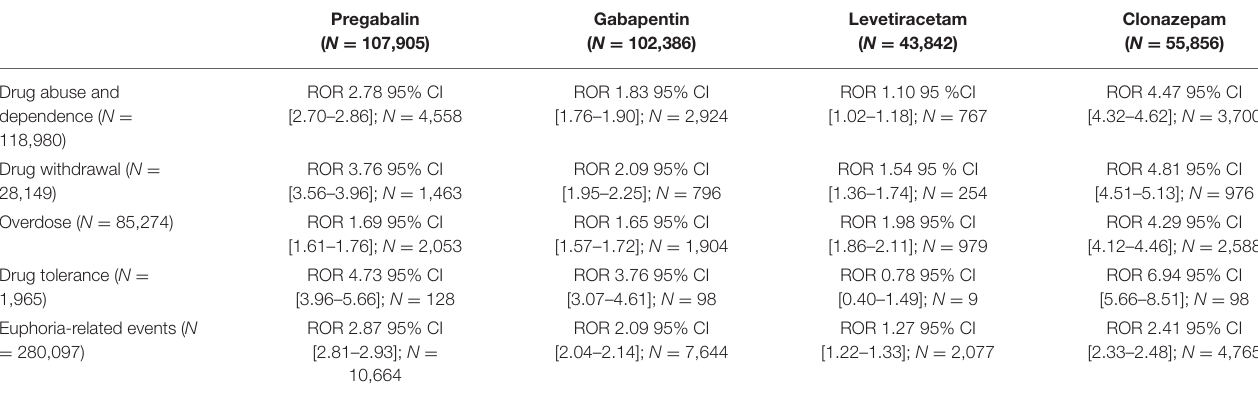
TABLE 2 | Number of reports and ROR & 95% CI related to drug abuse per